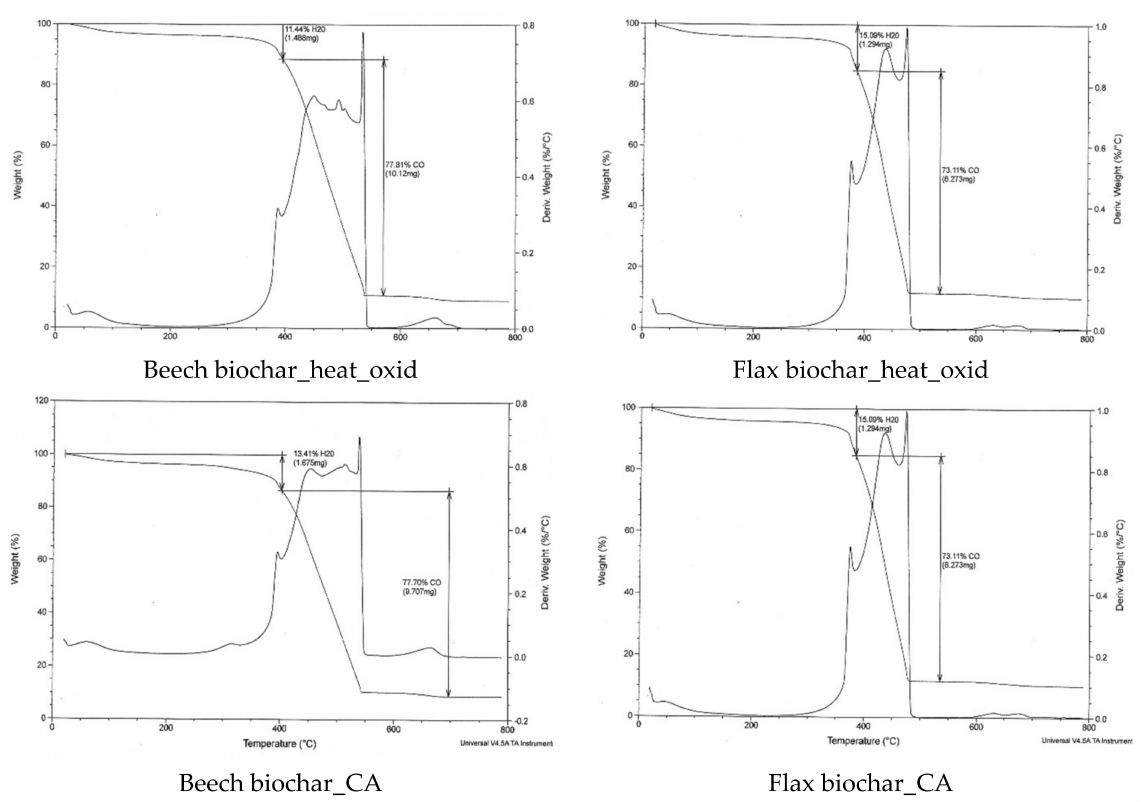
Figure 5. Thermogravimetric analysis of beech and flax biochars before and after modification.